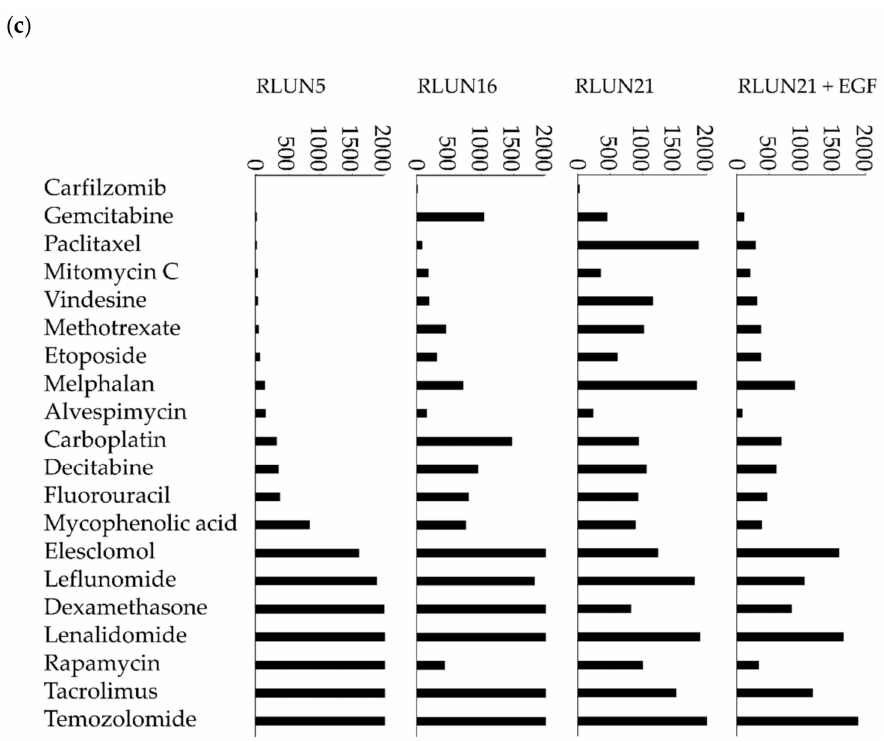
Figure 4. Response of F-PDOs to anti-cancer agents. The bar graphs represent the area under the activity curve measuring dose response (AUC) values calculated from the growth-inhibition assays, using 78 anticancer agents at concentrations ranging from 3 nM to 20 µ M. The AUC values show the area under each fitting curve calculated from each dose-response curve. The AUC value of a sample not treated with an anti-cancer drug was 2000. Low AUC values indicate cases where F-PDOs were more sensitive to an anti-cancer drug. Values above 2000 indicate cases where the cells grew more than the untreated sample. The data shown represent the mean of triplicate experiments. The column entitled “RLUN21 + EGF” indicates cases where the F-PDOs were grown in the presence of EGF. ( a ) Molecular target drugs that inhibit the EGFR signal pathway. ( b ) Other molecular target drugs. ( c ) Chemotherapeutic